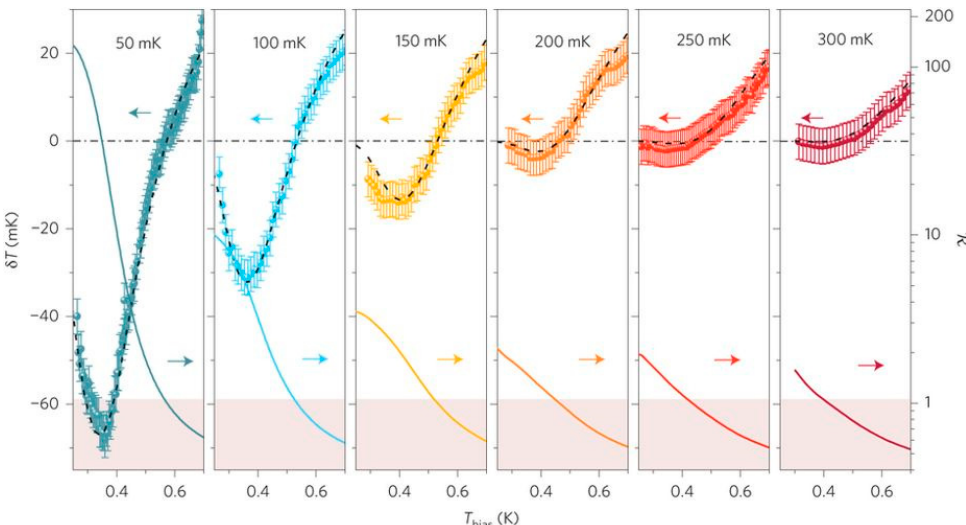
Figure 12. Experimental temperature difference as a function of bias temperature (left axis) measured at different ambient temperatures. Colored lines are the corresponding thermal rectification coefficients R (right axis, logarithmic scale). Reprinted with permission from Springer Nature Publishing Group.